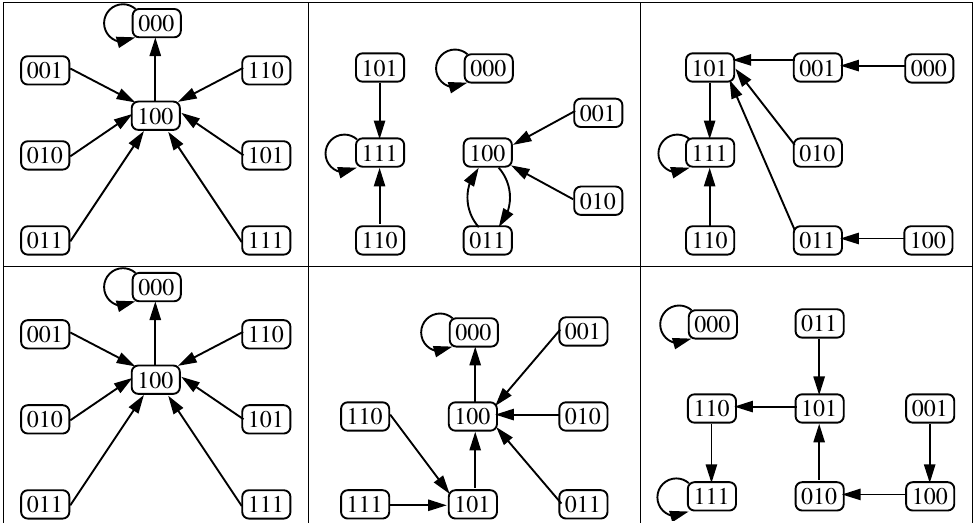
Figure 12. Dynamic of the improved reduced model associated with; low glucose and low lactose ( top left ), low glucose and medium lactose ( top center ), low glucose and high lactose ( top right ), high glucose and low lactose ( bottom left ), high glucose and medium lactose ( bottom center ) and high glucose and high lactose ( bottom right ).